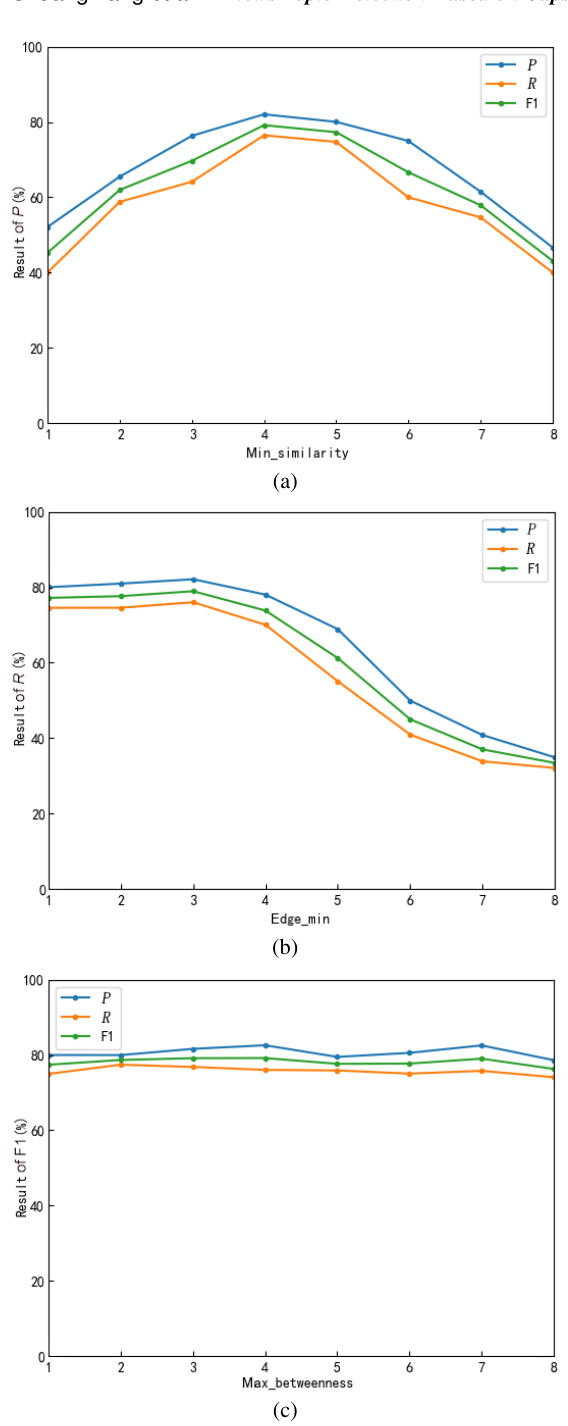
Fig. 5 Parameters sensitivity analysis of CSG on CEC. The abscissa represents the values of different parameters and the ordinate represents the values of three evaluation